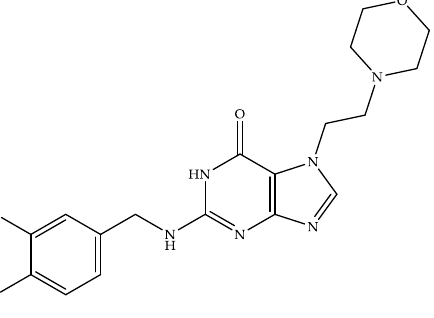
Figure 5. Chemical structure of ibezapolstat.